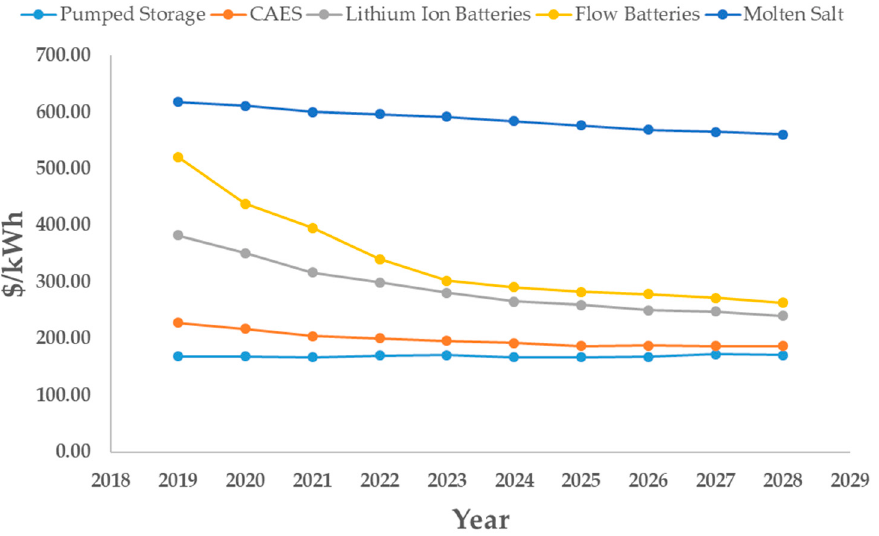
Figure 3. System installation cost ( CAPEX ) for different battery technologies in grid-scale energy storage systems. Source: Navigant Research.